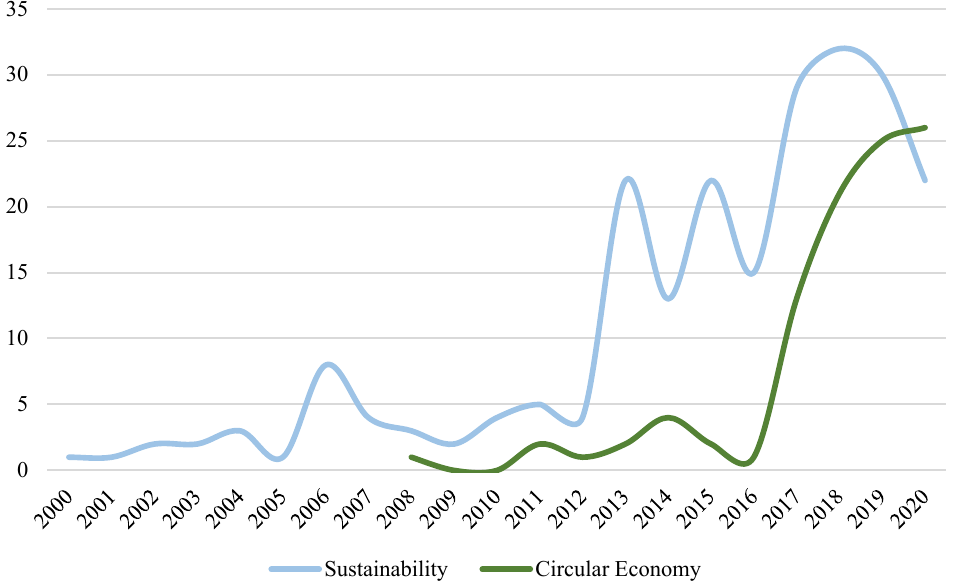
Figure 11. Relationship between PSS and sustainability and CE terms .